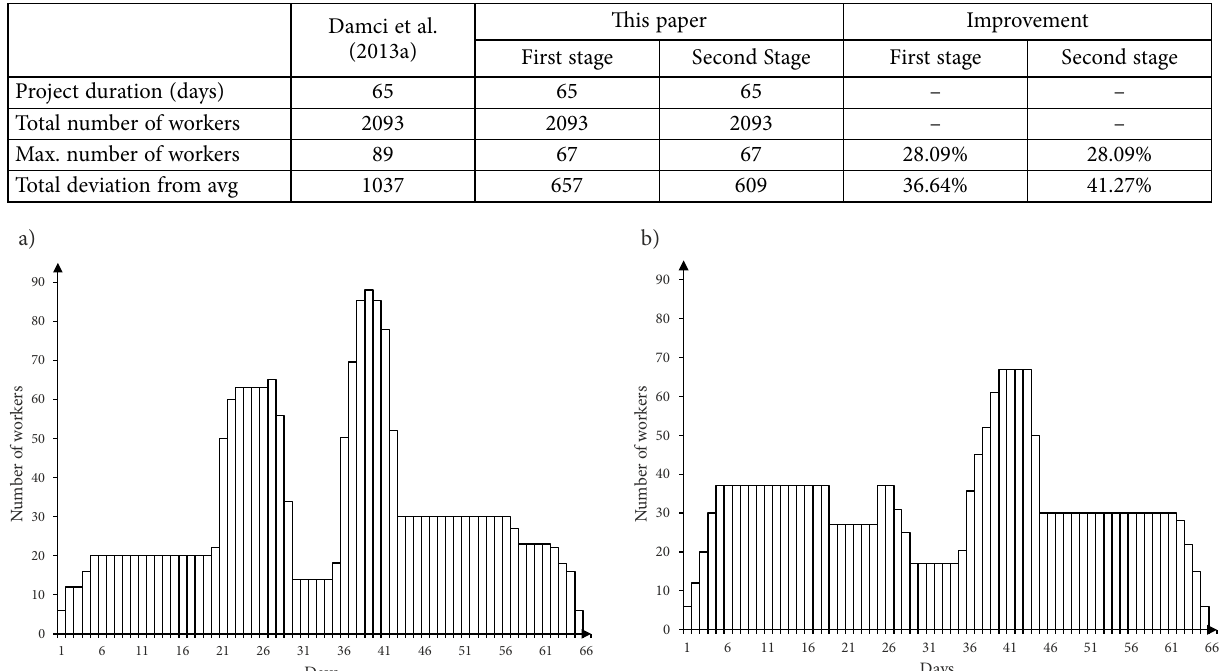
Figure 12. The first comparison: a – resource usage histogram of Damci et al. (2013a); b – resource usage histogram of the proposed